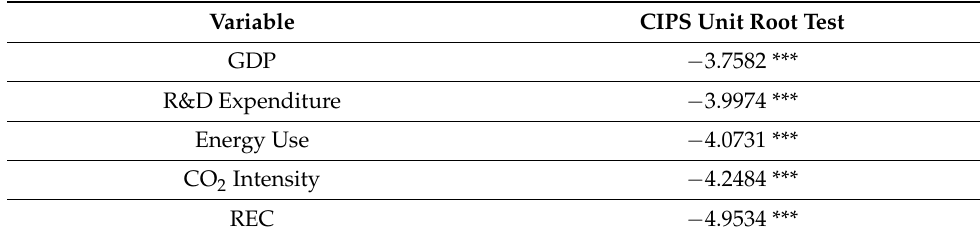
Table 2. Results of CIPS unit root